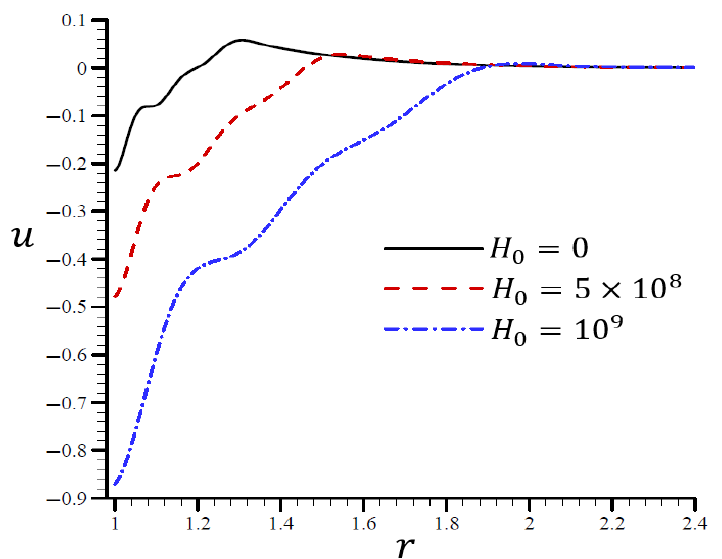
Figure 14. The influence of 𝐻 0 on radial displacement 𝑢 through the radial direction of the spherical hole using the RTPL model.